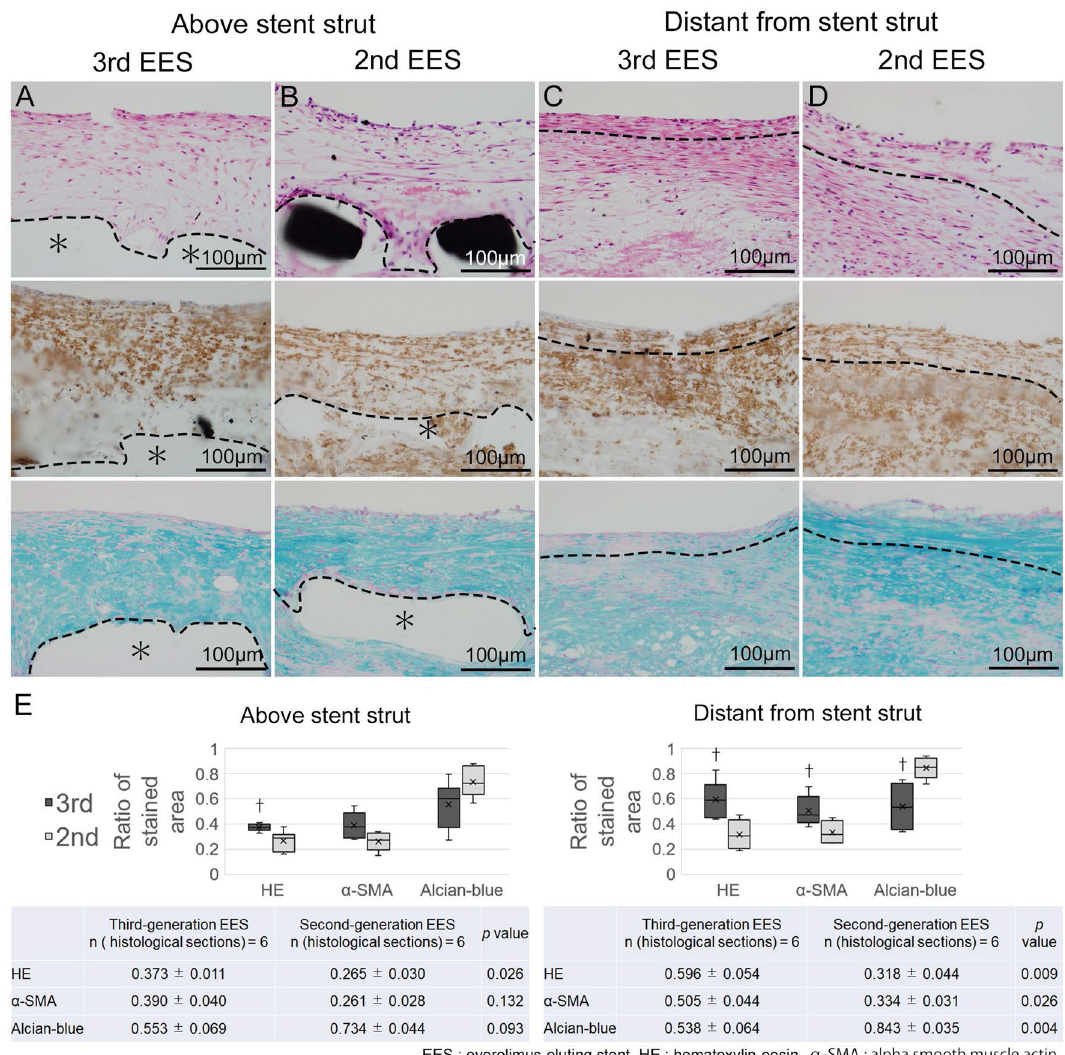
Figure 3. Neointimal tissue characteristics of the 4-week stent implantation group of low-density lipoprotein receptor knockout minipigs. ( A – D ) High-power magnification images of the neointima from the 4-week group of coronary arteries of low-density lipoprotein receptor knockout (LDLR −/−) minipigs implanted with the third-generation abluminal biodegradable-polymer everolimus-eluting stents (3rd EES, A , C ) and second- generation durable-polymer everolimus-eluting stents (2nd EES, B , D ) (upper panel: Hematoxylin–eosin, middle panel: alpha-Smooth muscle actin, lower panel; acian-blue). ( A , B ) Show the neointima above stent struts and ( C , D ) show the neointima distant from the stent struts. The part above the dotted line corresponds to the neointima and the part below to the intima and media. (A, C ) Neointima after the 3rd EES shows several compact layers of tightly arranged smooth muscle cells (SMCs), close to the luminal surface. ( B , D ) Neointima after the 2nd EES. Although thicker than that seen after the 3rd EES implantation, the neointima consists of proteoglycan-rich tissue and its density of SMCs is relatively low. ( E ) Neointima above the stent struts of the 3rd EES demonstrated significantly higher SMC density by hematoxylin–eosin staining than those with the 2nd EES. Neointima distant from the stent struts of the 3rd EES shows statistically significant differences with higher SMC and a lower density of alcian-blue-positive proteoglycans. † p < 0.05. ( A , B *; stent 12 stents from 9 autopsy cases with 2nd EESs (stent implanted period of 1–10 months) were examined. Clinical backgrounds of patients and stent characteristics are shown in Supplementary Tables 1 and 2, and in Table 1. Animal preparation and procedures. The LDLR −/− minipigs with human-like advanced coronary plaque development used in this study were previously described in detail by Li et al. 22 . All animals were housed at the Nihon University Medical Research Support Center, and standard animal husbandry procedures were followed. To accelerate the development of coronary artery plaques, 3-month-old male LDLR −/− minipigs (n (num- ber of animals) = 6) were fed a high-cholesterol, high-fat (HCHF) diet (1 kg/day) throughout the experiment